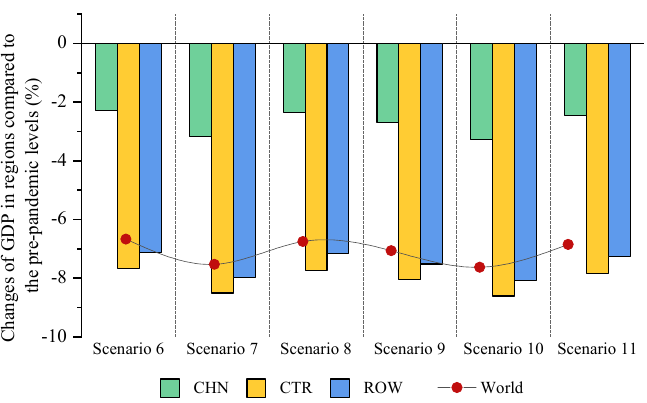
Figure 6. The impact of global pandemic spread on GDP in trade regions in the context of trade protectionism.